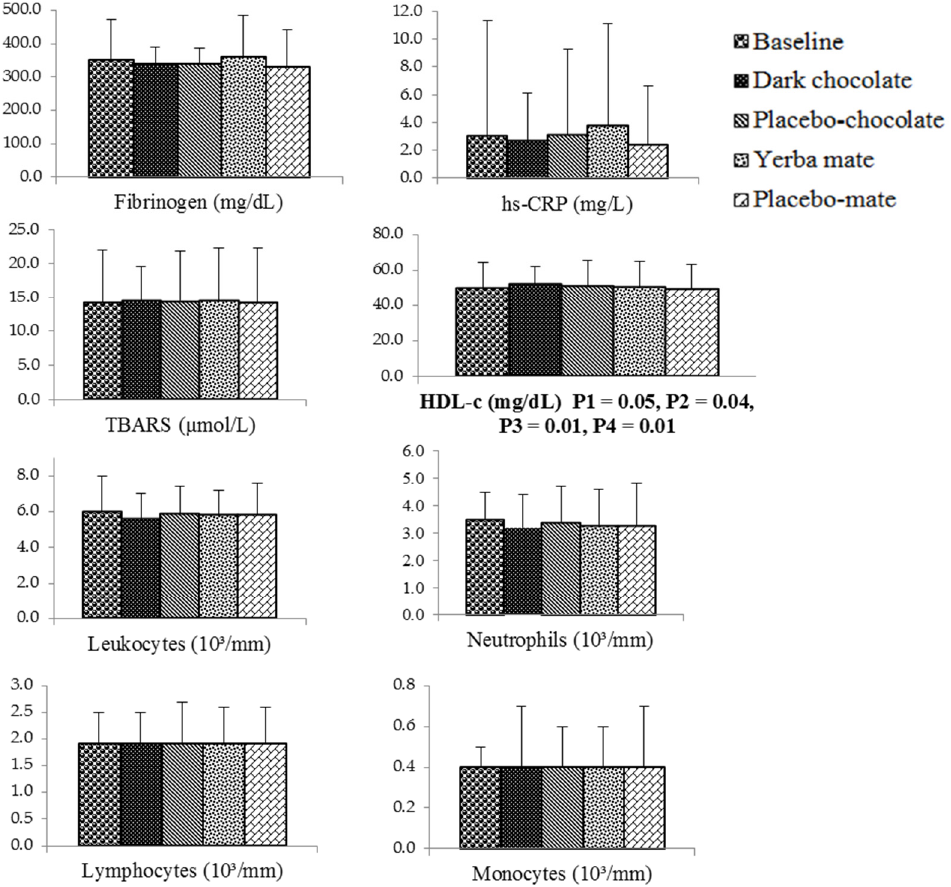
Figure 2. Bar graphs of inflammatory and oxidative variables of individuals with HIV/AIDS undergoing antiretroviral therapy at baseline and after receiving the different supplements ( n * = 92) ANOVA: P1, comparison of means between the four supplements. Bonferroni modified t -test: P2, dark chocolate versus yerba mate; P3, dark chocolate versus placebo-mate. Paired Student t -test: P4, baseline versus dark chocolate. hs-CRP, high-sensitivity C-reactive protein; TBARS, thiobarbituric acid reactive substances; HDL-c, high-density lipoprotein-cholesterol. n *: Fibrinogen (placebo-chocolate, n = 90, yerba mate, n = 89, placebo-mate, n = 89); neutrophils (yerba mate, n = 91) and monocytes (yerba mate, n = 91).